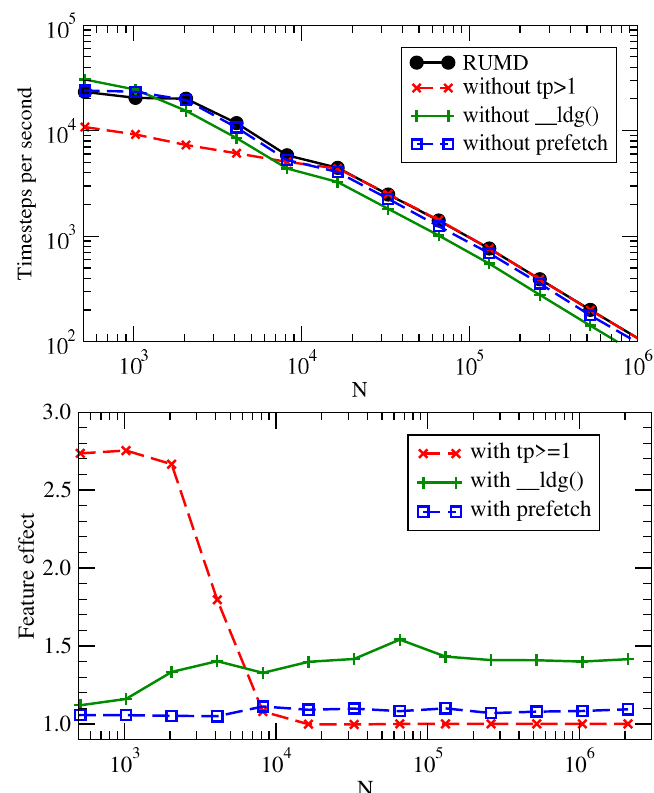
Figure 7: Analyzing the effect of optimization features in RUMD. The upper panel shows the performance of the full-RUMD and three other versions in which one feature has been > 1), use of read only data-cache to read positions disabled: multiple threads per particle ( t p (__ldg()), and pre-fetching. The lower panel shows the same data in terms of the relative boost in performance that each feature gives, as a function of system size.